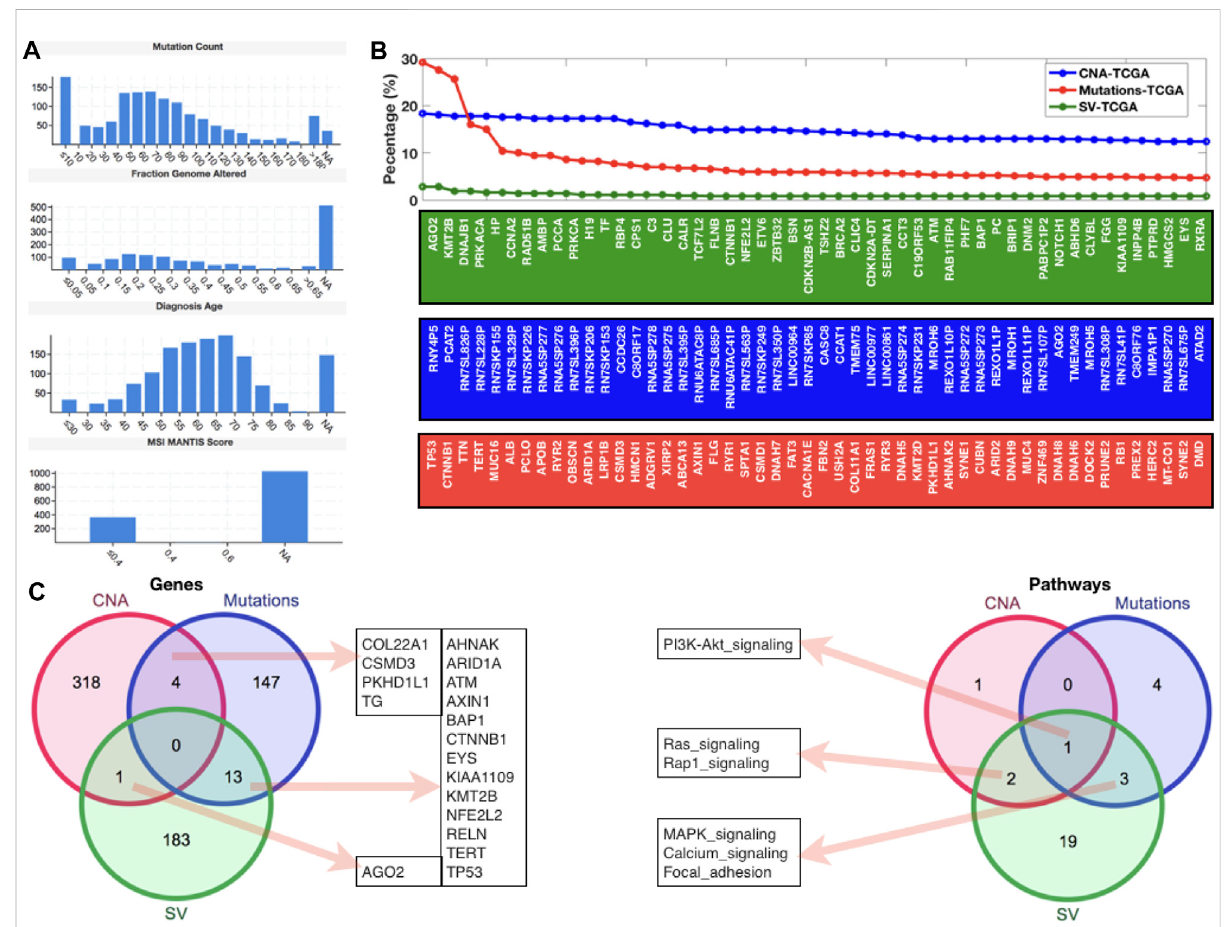
FIGURE 2 Genomic-levelalterationsinHCCdatasetsofTCGAdatabase. (A) Histogramstopresentthemutationcount,fractiongenomealtered,diagnosis age,andMSImantisscore. (B) Percentageofpatientswithdifferenttypesofalterations(CNA,Mutations,andSV)incaseofHCC. (C) Venndiagramsto display the shared and speci fi c signi fi cant genes and